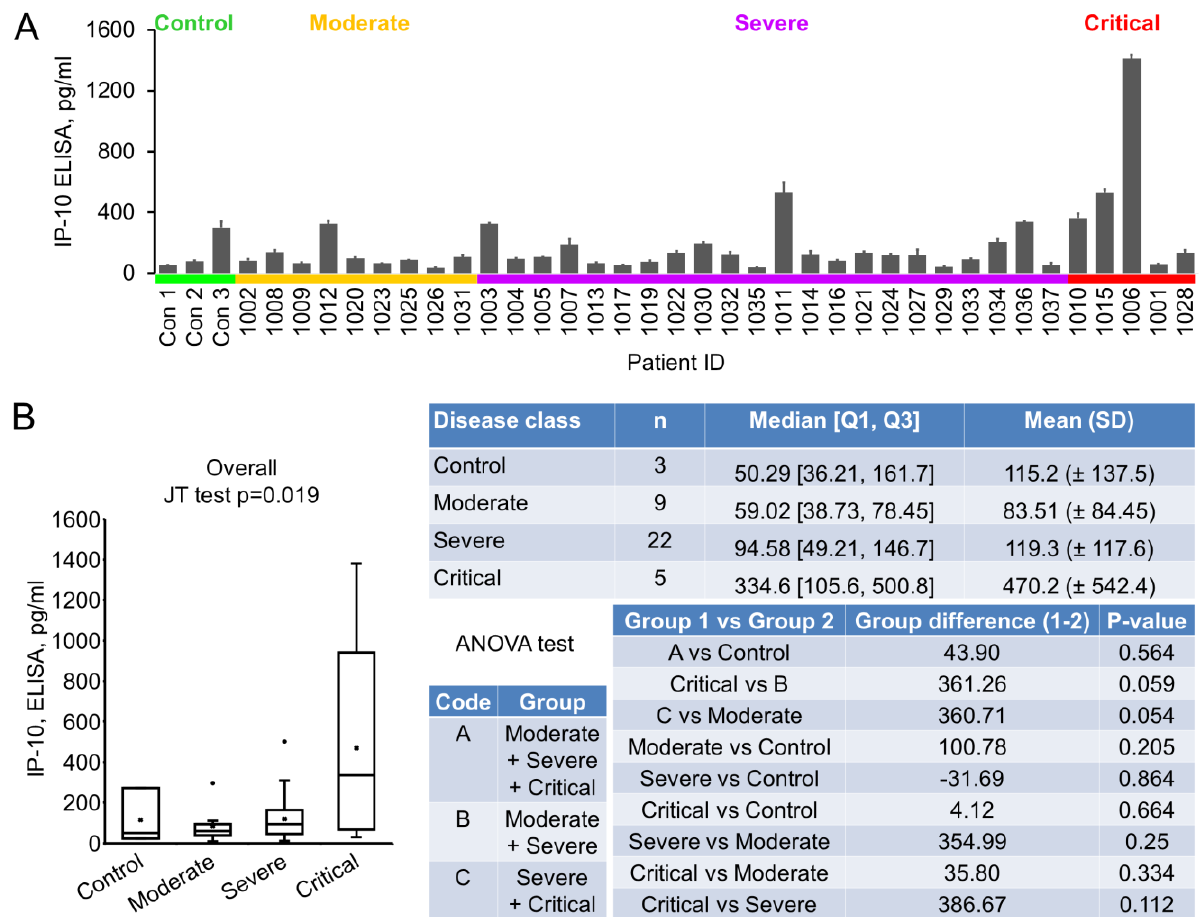
FIGURE 2: IP-10 levels in early plasma samples. (A) IP-10 levels were measured using ELISA kits. Plasma (10 µl) were diluted to 100 µl and added to anti-IP-10 antibody coated wells in duplicate. Data were groups by disease stage and expressed as mean ± SD. (B) Statistical analy- sis of IP-10 levels with disease